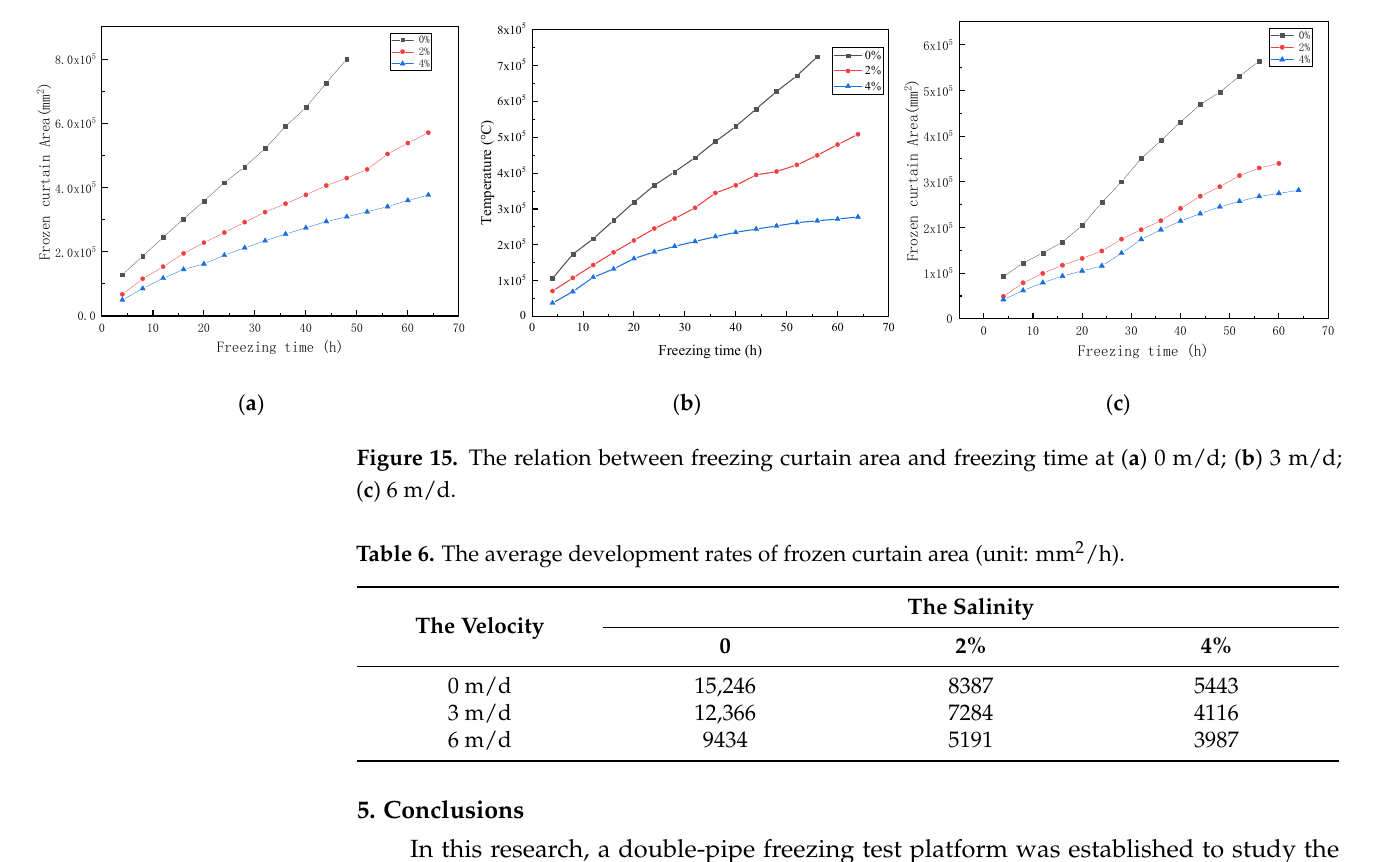
Table 6. The average development rates of frozen curtain area (unit: mm 2 /h). The Velocity